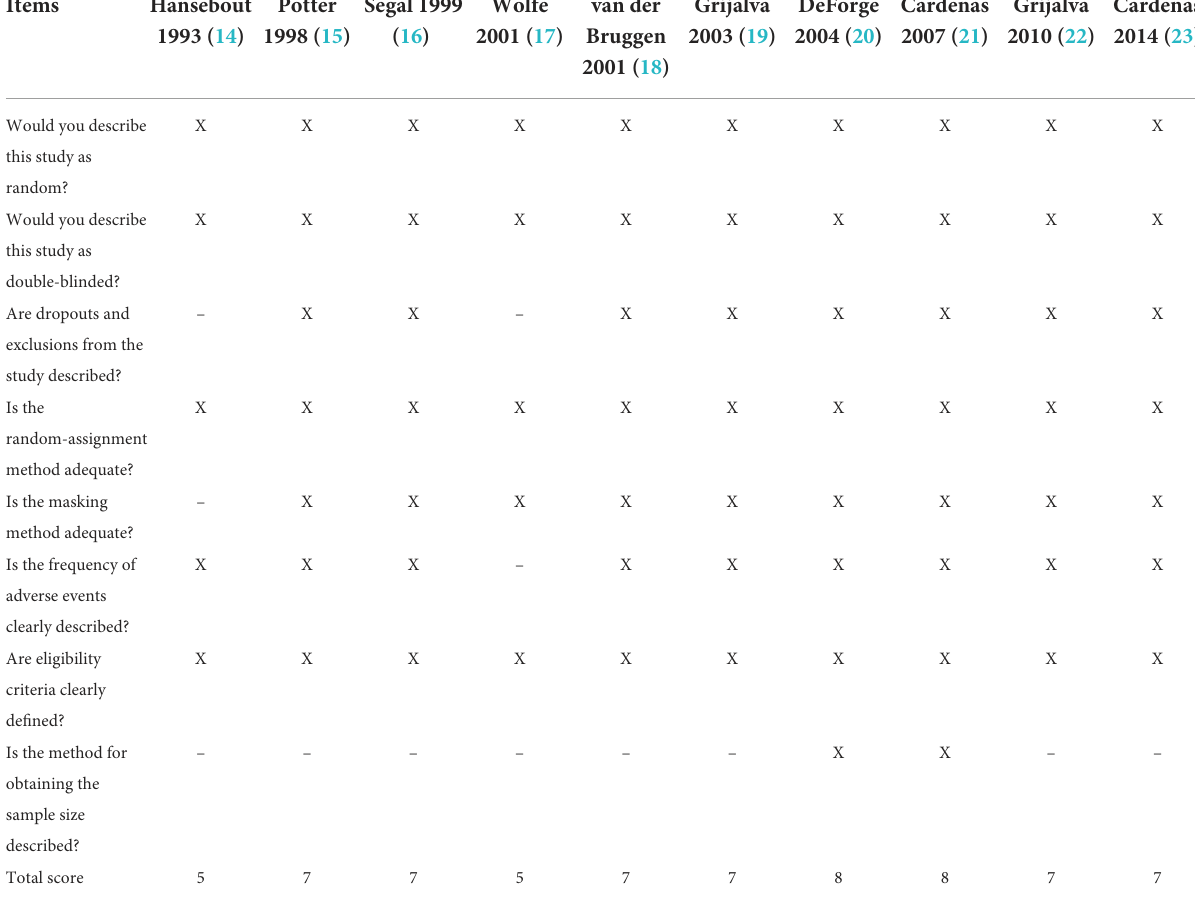
TABLE 1 Clinical trial quality evaluation using the Modified Jadad